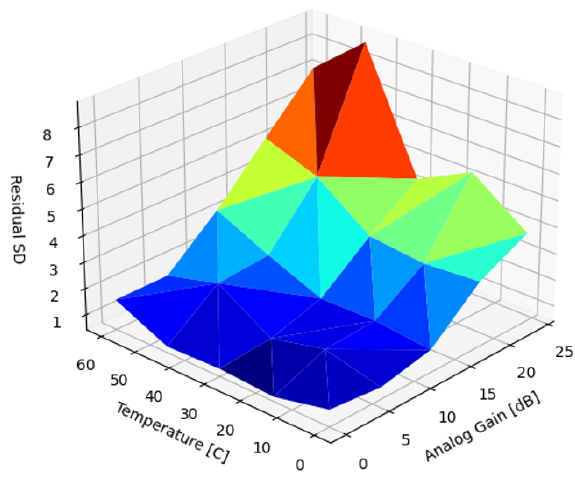
Figure 14. SD of DSNU corrected with linearly interpolated reference, using 5 reference